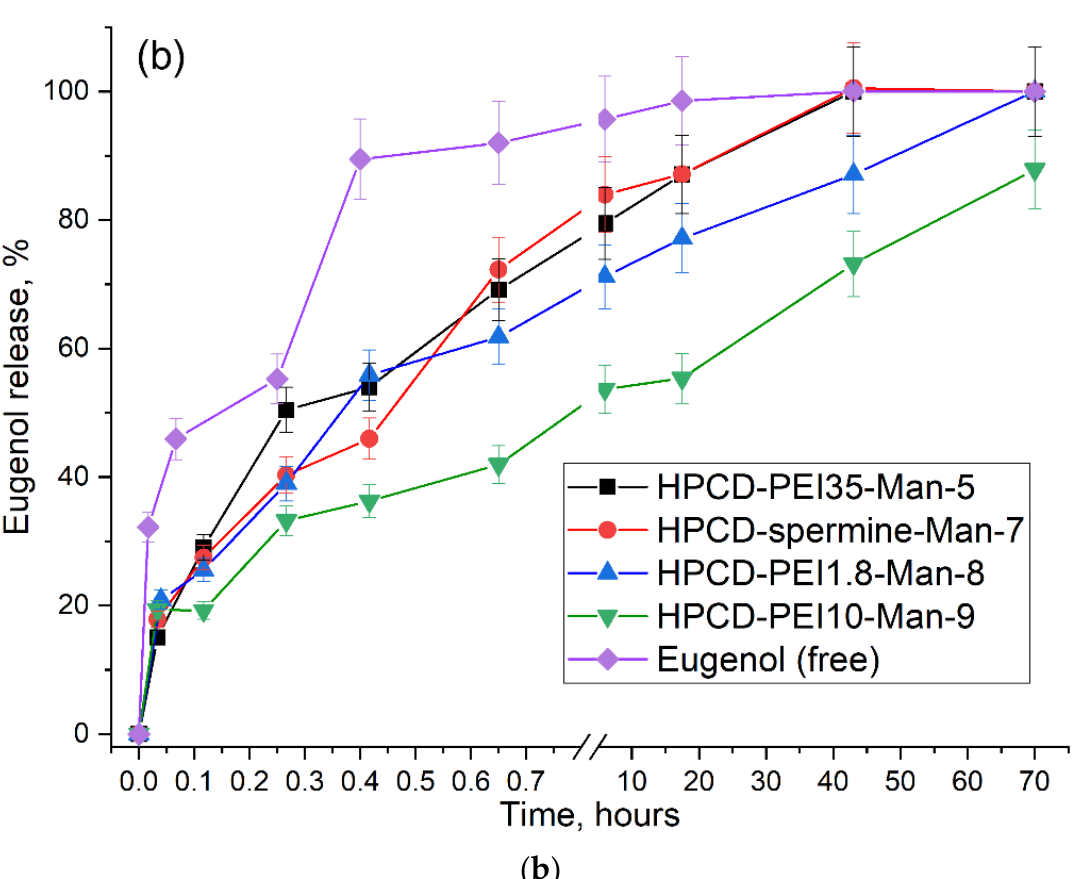
Figure 7. Release kinetics curves of ( a ) free levofloxacin and levofloxacin complexes (1:1 by mass) with molecular containers 5 , 7–9 ; and ( b ) free eugenol and eugenol complexes (1:1 by mass) with molecular containers 5 , 7–9 . Dialysis membrane (12–14 kDa cut-off) into an external solution (1:5 by volumes). PBS (pH = 7.4). Levofloxacin and eugenol are detected by UV-absorption at 287 and 280 nm, correspondingly. C 0 (Lev) = 0.2 mg/mL. C 0 (eugenol) = 2 mg/mL. T = 37 °C. Values are presented as the mean ± SD of three experiments. Table 4. Kinetics parameters of release curves of (a) free levofloxacin and levofloxacin complexes (1:1 by mass) with molecular containers 5 , 7–9 ; and (b) free eugenol (EG) and eugenol complexes (1:1 by mass) with molecular containers 5 , 7–9 . Dialysis membrane (12–14 kDa cut-off) into an